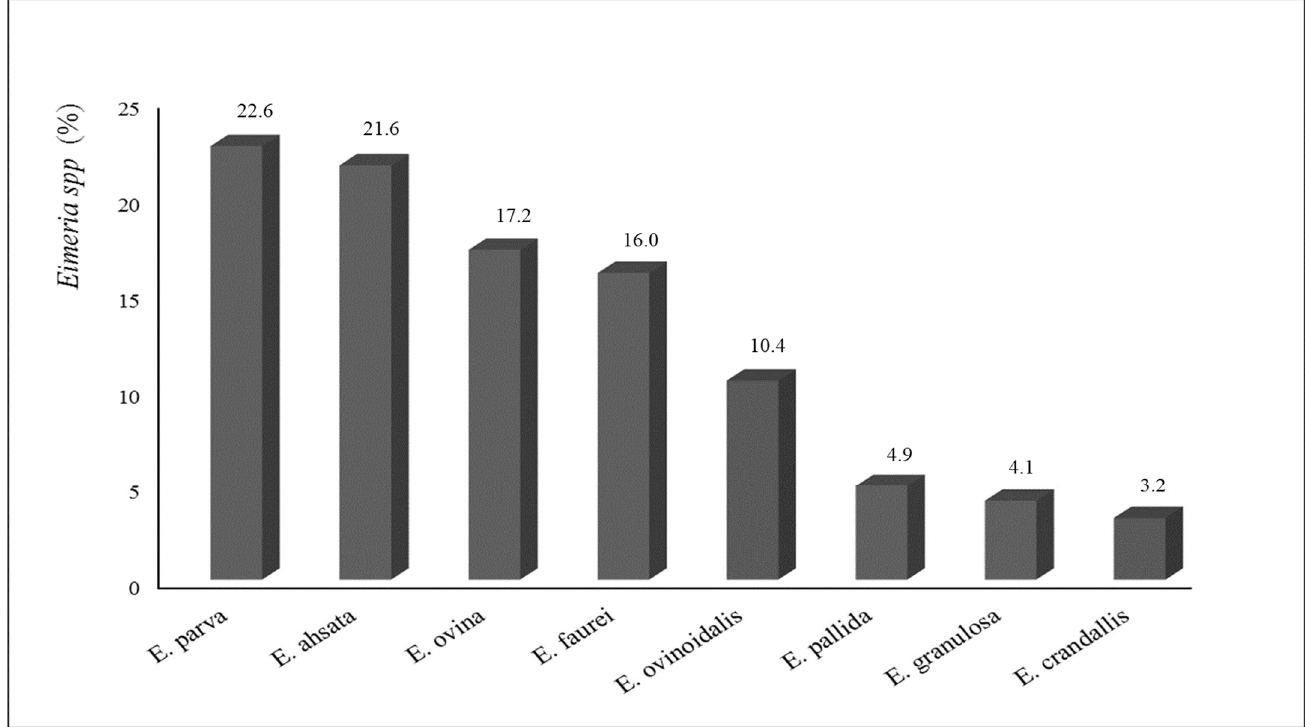
Figure 1. Eimeria species identified.